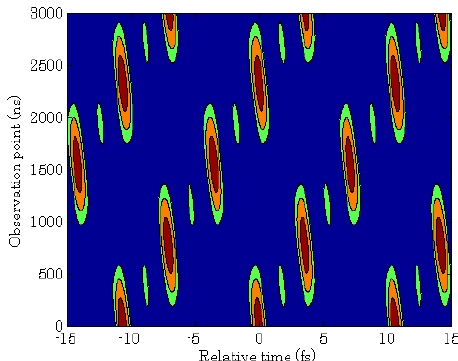
Figure 5. Numerical simulations of a subcycle cosine pulse electric field generated by this multi-harmonic optical comb with a frequency deviation of 437 kHz. The vertical scale is the time evolution of the pulse train from 0 to 3000 ns. The horizontal scale is the local time of the waveform displayed for about three cycles. The field pattern shifts with a phase shift of 2π/3 every 1/3 of a period by repeats and replicates itself in approximately 2288 ns which corresponds to the inverse of the frequency deviation used in the simulation. Normalized electric field strength shown here is color-coded to assist in recognition of the evolution of the field pattern as follows: dark red regions represent the value is from 0.8 to 1.0; orange regions represent the value is from 0.5 to 0.8; green regions represent the value is from 0.253 to 0.5 and blue regions represent the value is from 0.0 to 0.253.